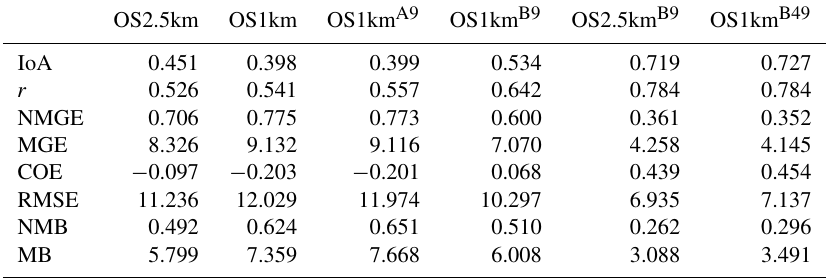
Table B6. Surface O 3 observations to model comparison, nighttime (18:00–09:00LT) (ppbv, 1247 model–observation pairs).